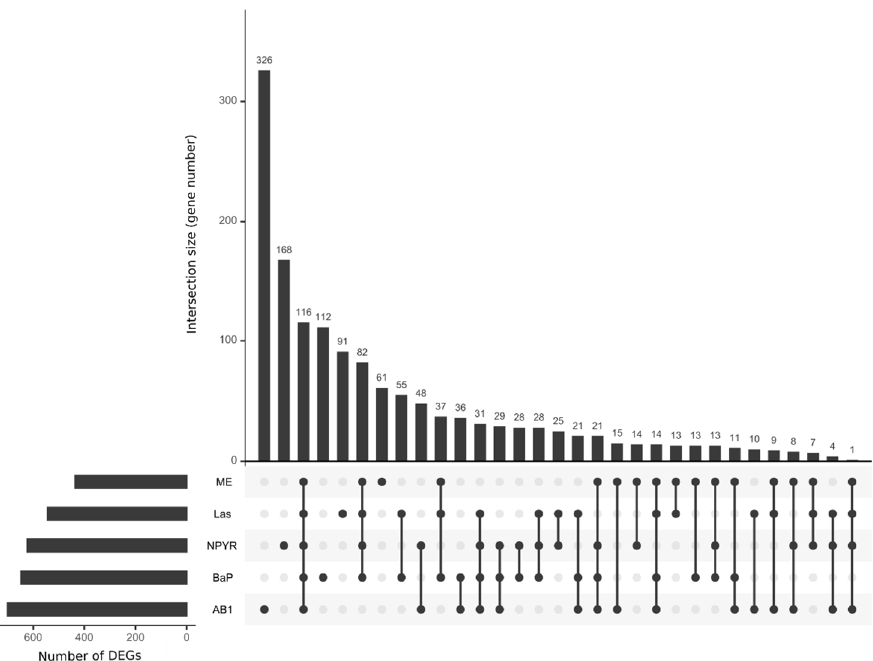
Figure 2. Commonalities of differentially expressed genes of GTX in an UpSet plot. RNA sequencing with lymphoblastoid TK6 cells was performed using genotoxic and non-genotoxic compounds, but only genotoxic compounds revealed many differentially expressed genes ( p adj < 0.05 and |FC| > 1.5; cp. Figure 1). These genes were visualized for overlap in an UpSet plot using R package UpSetR version 1.4.0 with the genotoxic compounds AB1, BaP, NPYR, Las, and ME. The number of DEGs is depicted on the left, the number of intersections in the upper half. The plot shows 116 genes that are commonly regulated by all five compounds.